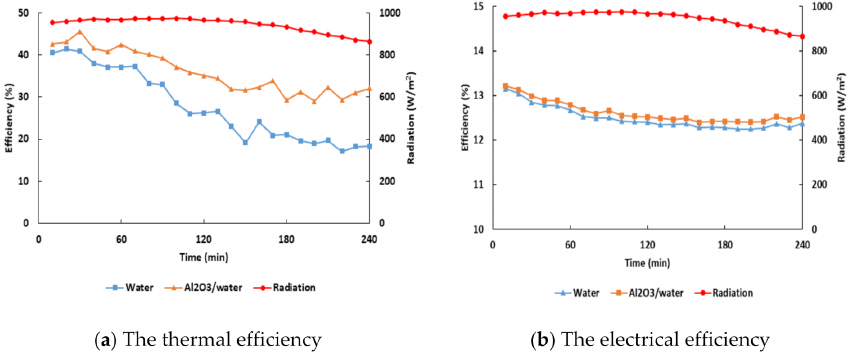
Figure 5. The efficiency and radiation of the PVT system using water and Al 2 O 3 -water nanofluid over time, where ( a ) shows the thermal efficiency, while ( b ) shows the electrical efficiency. Table 7. The average efficiency of the PVT system using water and Al2O3-water